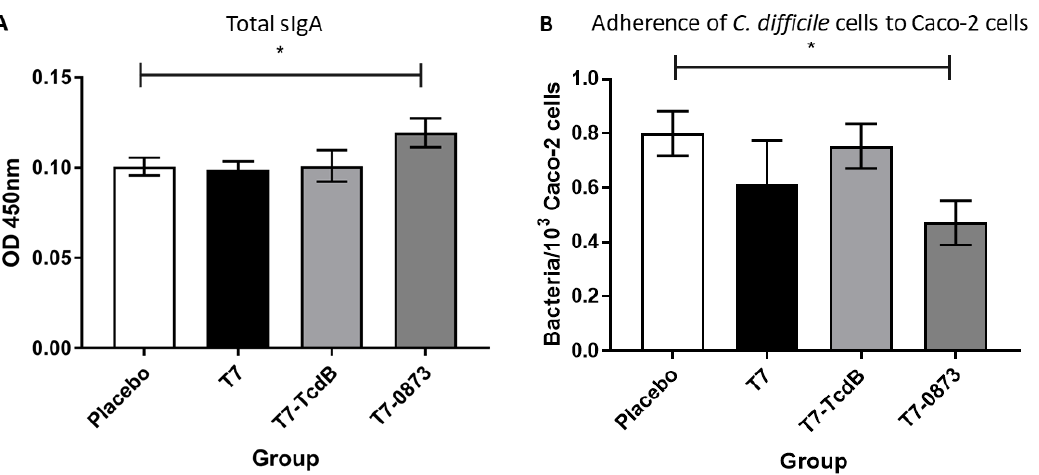
Figure 4. Intestinal immune responses in hamsters 2 weeks after oral immunisations with 10 6 spores of strains T7, T7-TcdB and T7-0873: 3 doses, 2 weeks apart. ( A ) Total sIgA in intestinal lavages diluted 1:2 was measured by an anti-hamster sIgA ELISA kit (MyBioSource). ( B ) Adherence of C. difficile strain 630 to Caco-2 monolayers after the bacterial cells were pre-incubated with intestinal lavages diluted 1:2. Cell binding was measured by enumerating CFU from washed Caco-2 cells. Error bars represent the standard deviation (SD). The data were analysed by nonparametric ANOVA (Kruskal–Wallis) with Dunn’s uncorrected comparison. Statistical difference p value: * p <